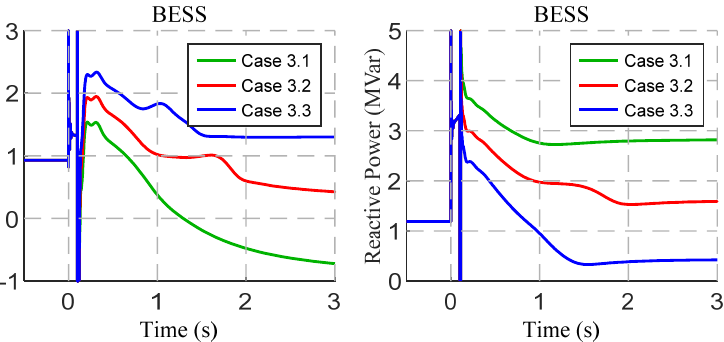
Figure 21. BESS power converter active and reactive power outputs for different shapes of the CI-RES voltage/reactive current hysteresis tuning.